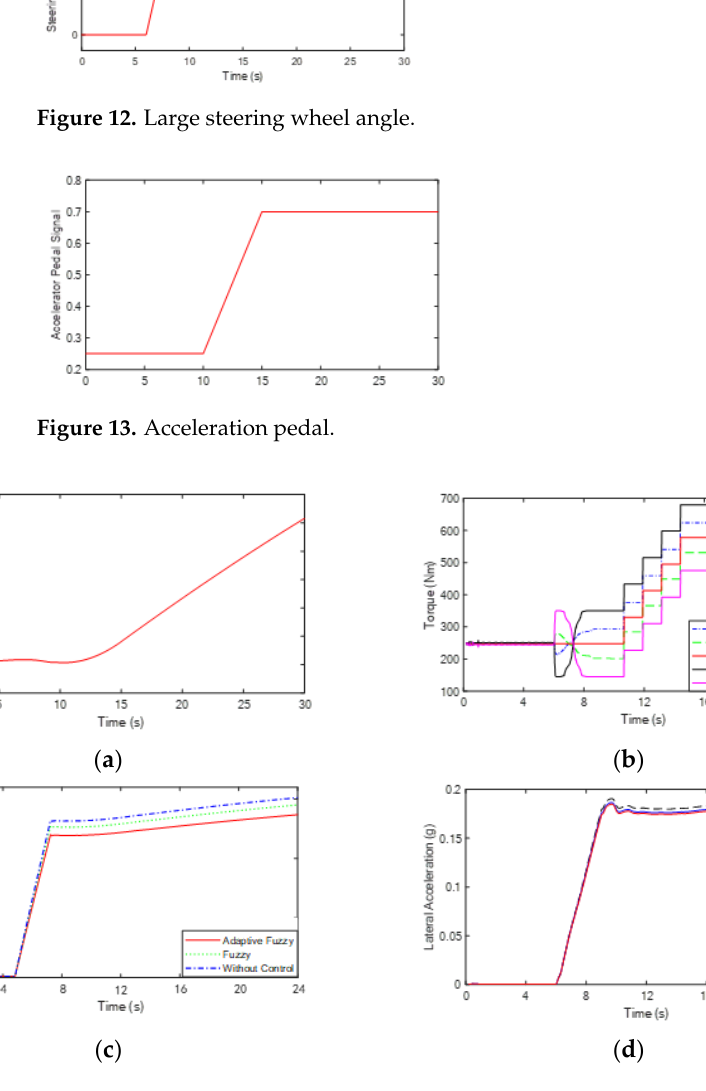
Figure 14. ( a ) Speed, ( b ) torque; ( c ) yaw rate, and ( d ) lateral acceleration. Table 3. Comparison of the simulation results with a large steering angle at low speed.